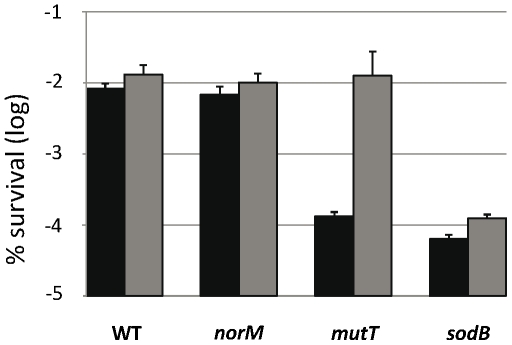
Viability after H2O2 treatment.The data represent survival percentages after 30 min of 50 mM H2O2 treatment. Data for strains NR10831, NR10831ΔnorM, NR10831ΔmutT, and NR10831ΔsodB harboring either the empty vector pCA24N (black) or the plasmid expressing norM, pCNorM, (gray) are shown. Survival is represented as the percentage of cfu after H2O2 treatment relative to before treatment. The error bars indicate one standard error of the mean of four independent replicates.